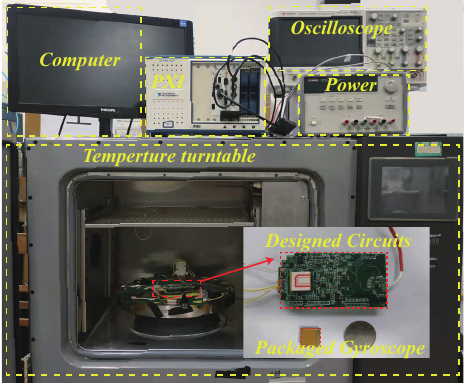
Figure 10. The picture of experimental platform.